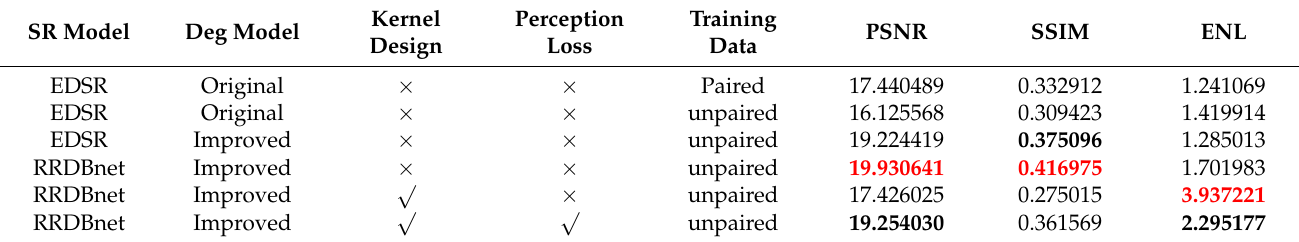
Table 8. Influence of training data on experimental